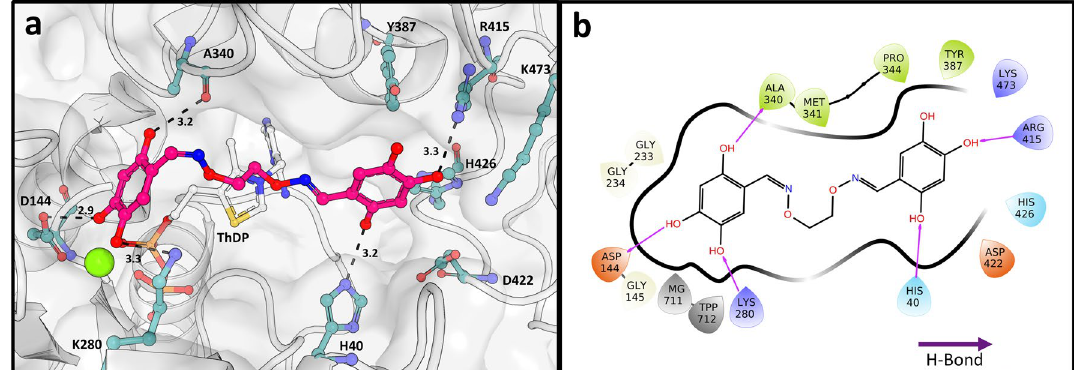
Figure 7. Docking of the hydroxybenzaldoxime 1 to ∆ Mt DXPS. ( a ) Hydroxybenzaldoxime 1 docked in the active site of ∆ Mt DXPS with cofactor ThDP bound (PDB ID: 7A9H). The pose of the docked molecule with the highest affinity score, as calculated by HYDE, is shown in pink and the predicted interacting residues are shown in stick presentation and are labeled. Hydrogen bonds are shown as black, dotted lines with distances indicated in Ångström. ( b ) 2-Dimensional ligand interaction plot of Hydroxybenzaldoxime 1 with ∆ Mt